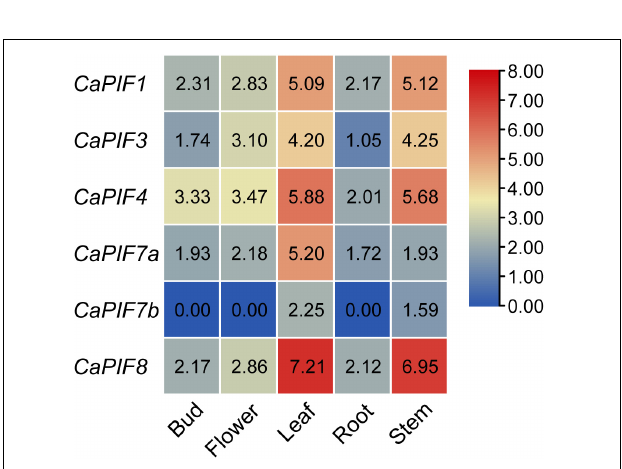
FIGURE 4 | Relative expression levels of CaPIF genes in different tissues based on RNA-seq data. RNA-seq data of five tissues in pepper cultivar “Zunla” were used to analyze the expression pattern. Roots, stems, and leaves were collected from plants at the full-bloom stage, and the unopened flower buds (buds) and fully open flowers (flowers) were collected from mature plants. The heat map was drawn in log2 transformed expression values.